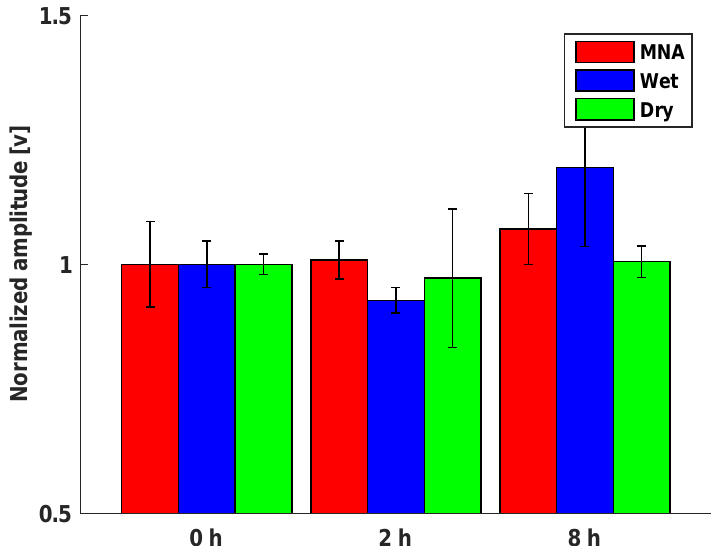
Figure 12. Temporal changes in the baseline RMS amplitudes. Bars: ± 1 SD, n = 5.